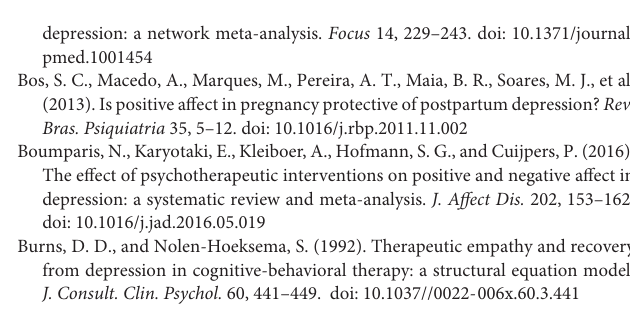
FIGURE S1 | Descriptive summaries of the treatment outcome measures of PsyCap for the PCI